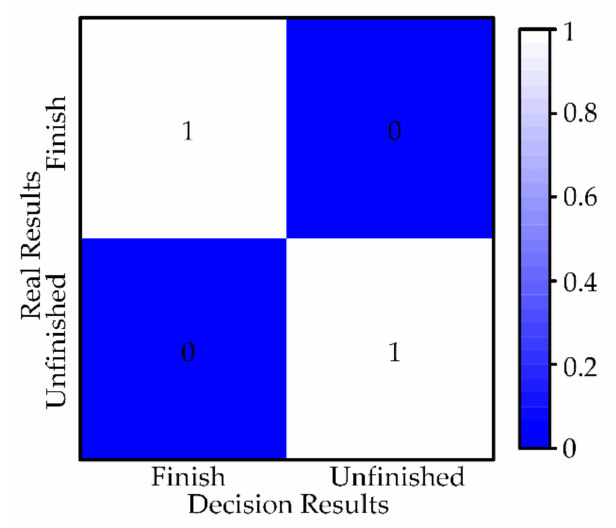
Figure 12. Confusion matrix for fusing decision results.